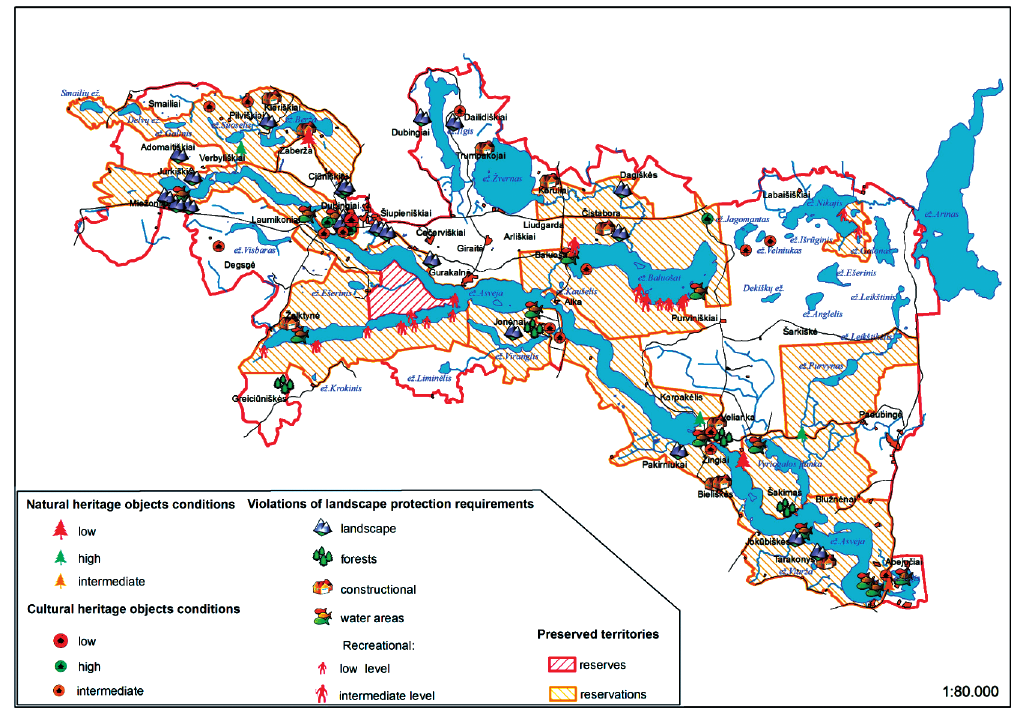
Fig. 1. Territorial distribution of violations in Asveja Regional